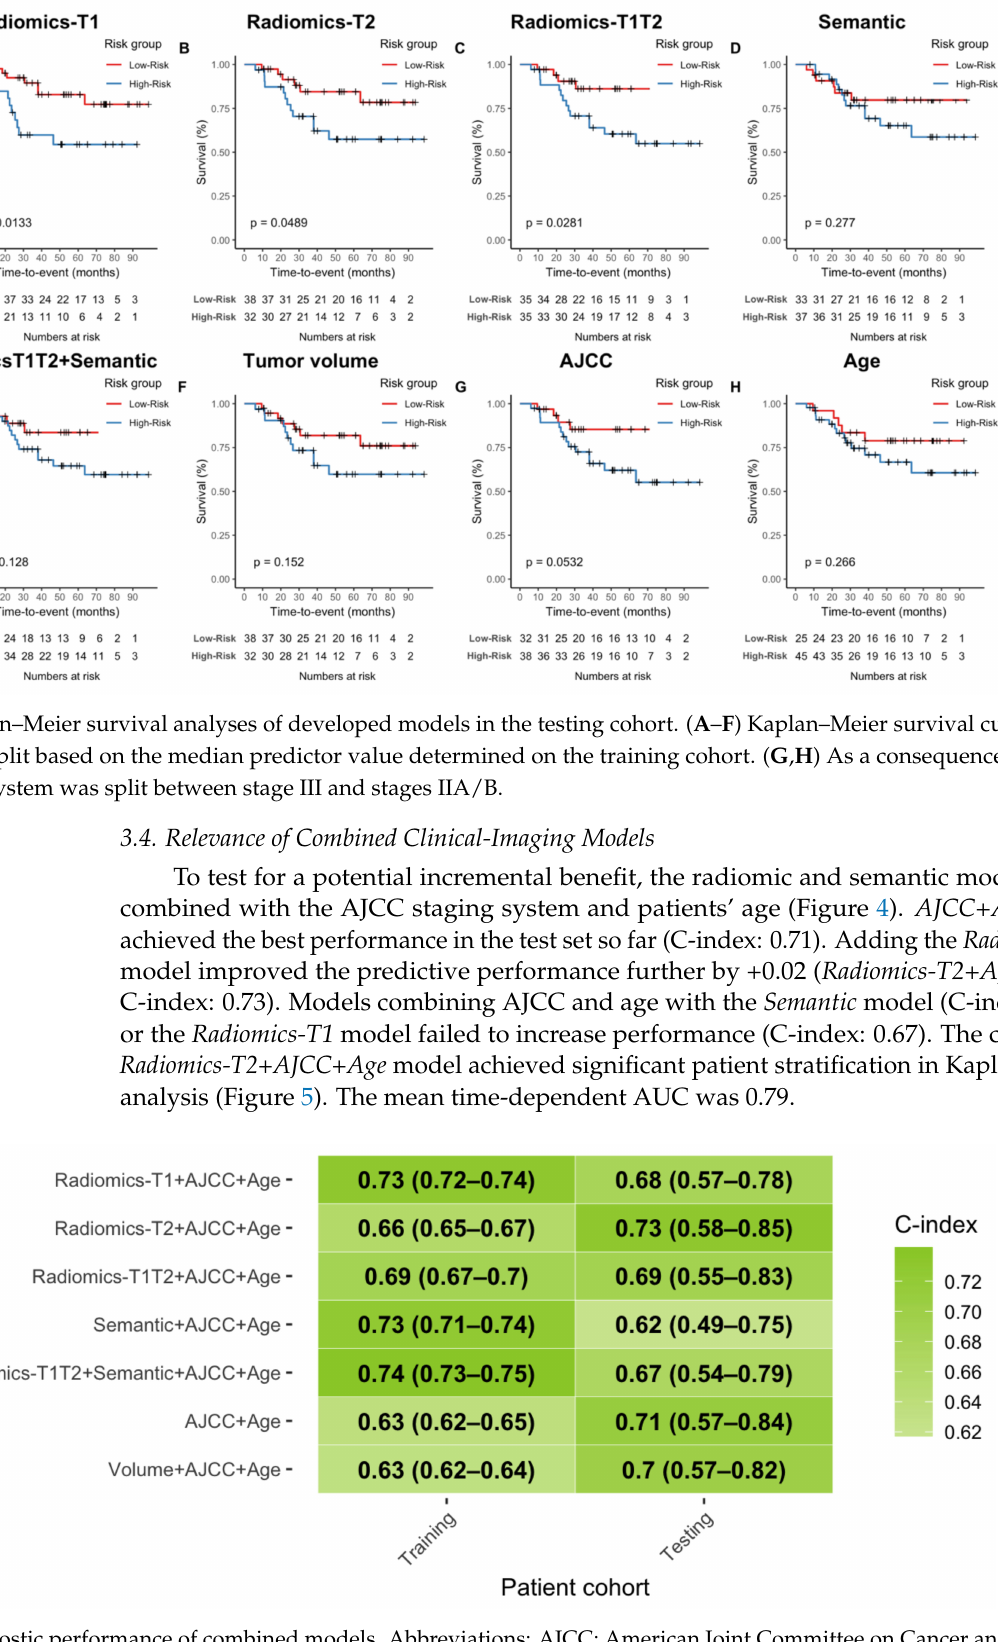
Figure 4. Prognostic performance of combined models. Abbreviations: AJCC: American Joint Committee on Cancer and